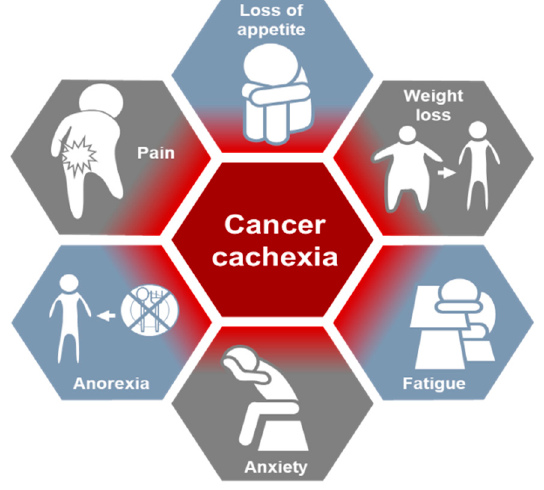
Figure 1. The common assessment for the clinical management of cancer cachexia.